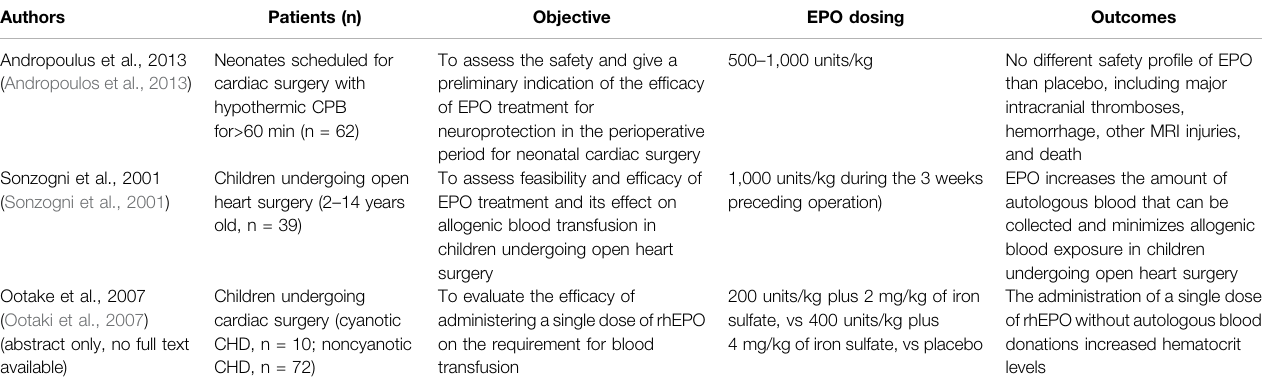
TABLE 1 | Studies involving EPO administration in children with CHD.